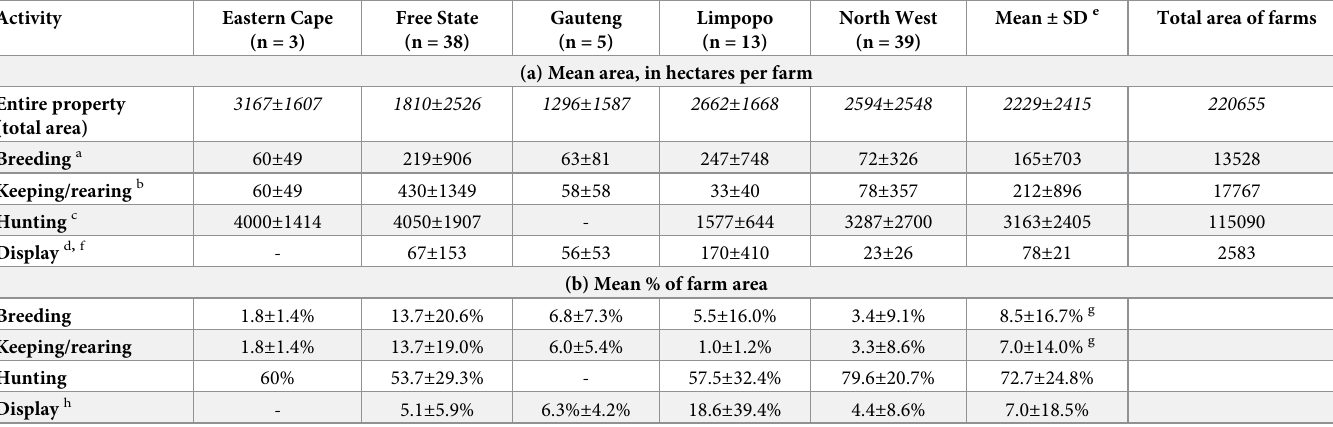
Table 2. Mean ( ± SD) (a) sizes of 99 properties and, depending on the province and farm purpose, the areas set aside for breeding, keeping, hunting and/or display- ing lions, and (b) percentage of the total farm area set aside for the listed activities. Not every activity took place on the respondents’ properties. Results correspond